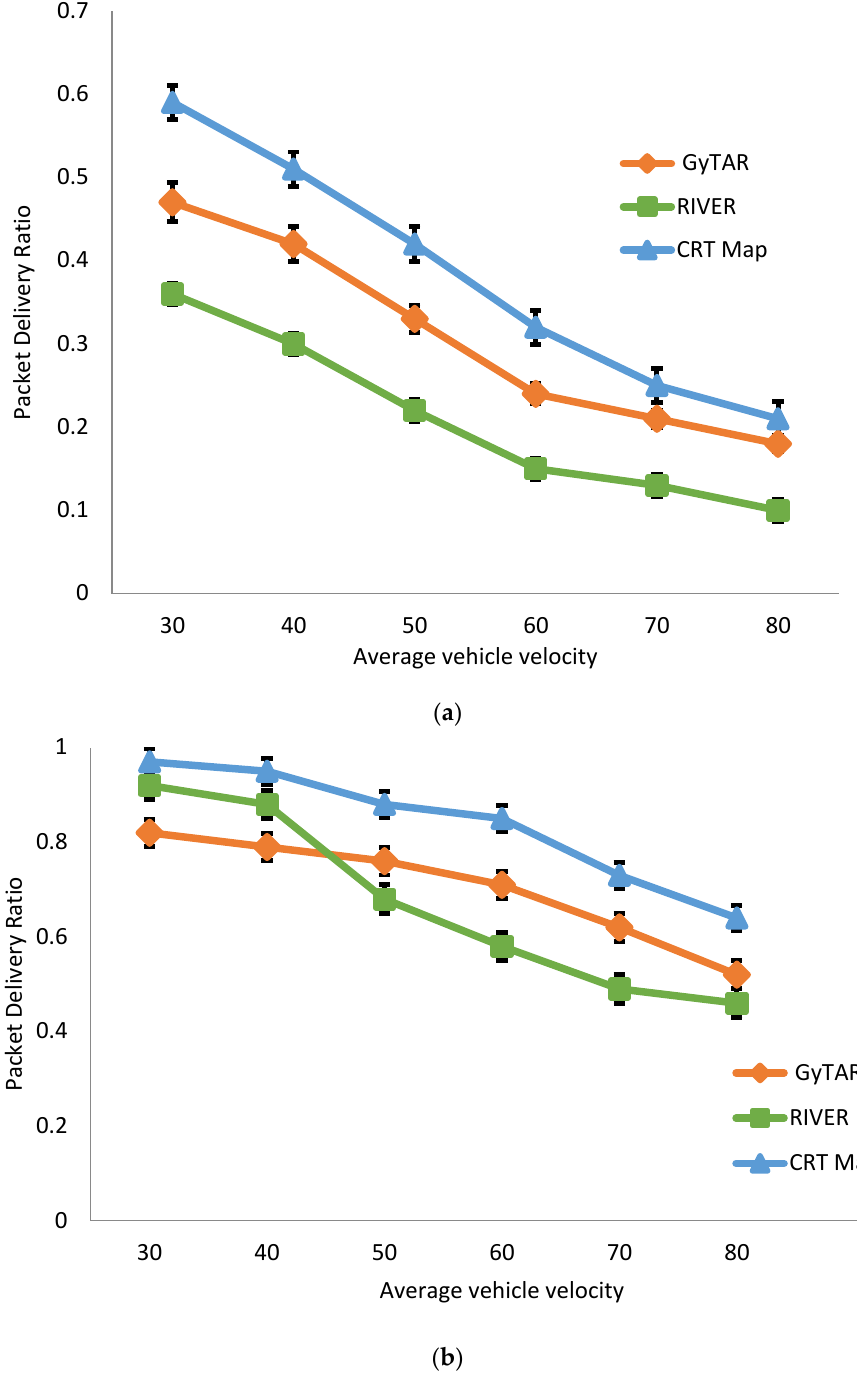
Figure 9. Delivery ratio vs. moving speed: ( a ) 100 vehicles; and ( b ) 300 vehicles.